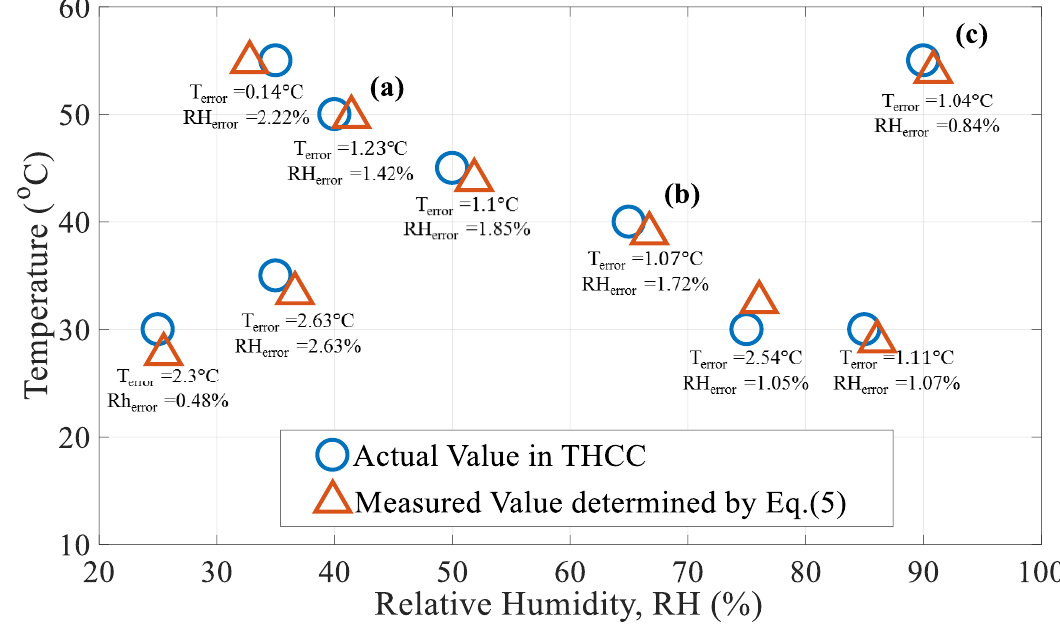
Figure 6. Sample data for measurement comparison.